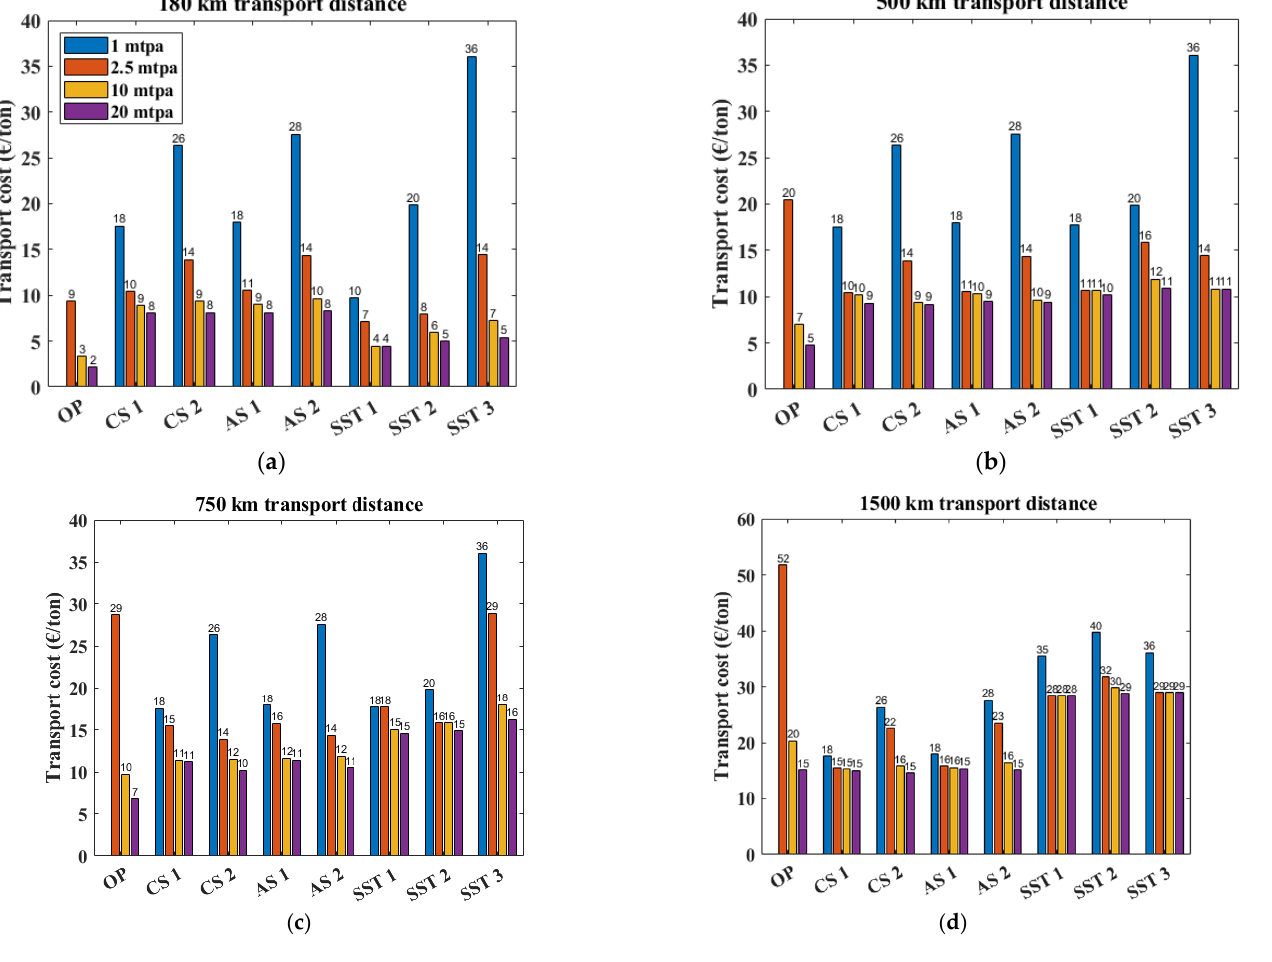
( d ) Figure 8. Number of vessels required on different source volumes and transport distances: ( a ) 180 km; ( b ) 500 km; ( c ) 750 km; ( d ) 1500 km. 4.2.2. Short Distances (180 km) The SST has the lowest cost for the smallest CO 2 volumes of 1–2.5 mtpa. The main reason for the low cost is because this small volume can be served by 1–2 of the smallest